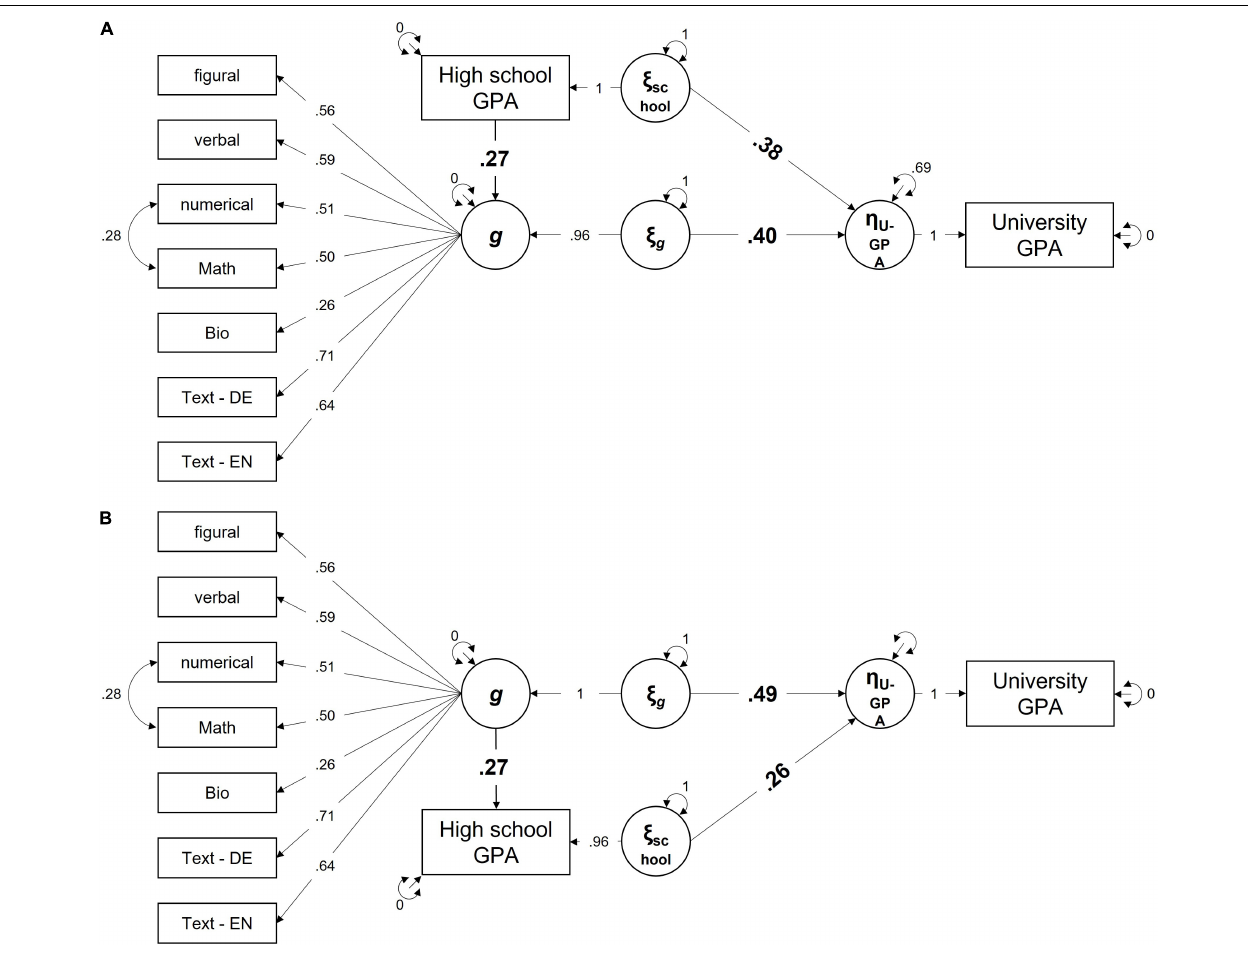
FIGURE 2 | Model-based test of incremental validity of (A) g over high school grade point average (GPA) and (B) high school GPA over g . χ 2 ( 25 ) = 40.68, p = 0.025, CFI = 0.958, RMSEA = 0.041. All estimates are standardized and significantly greater than